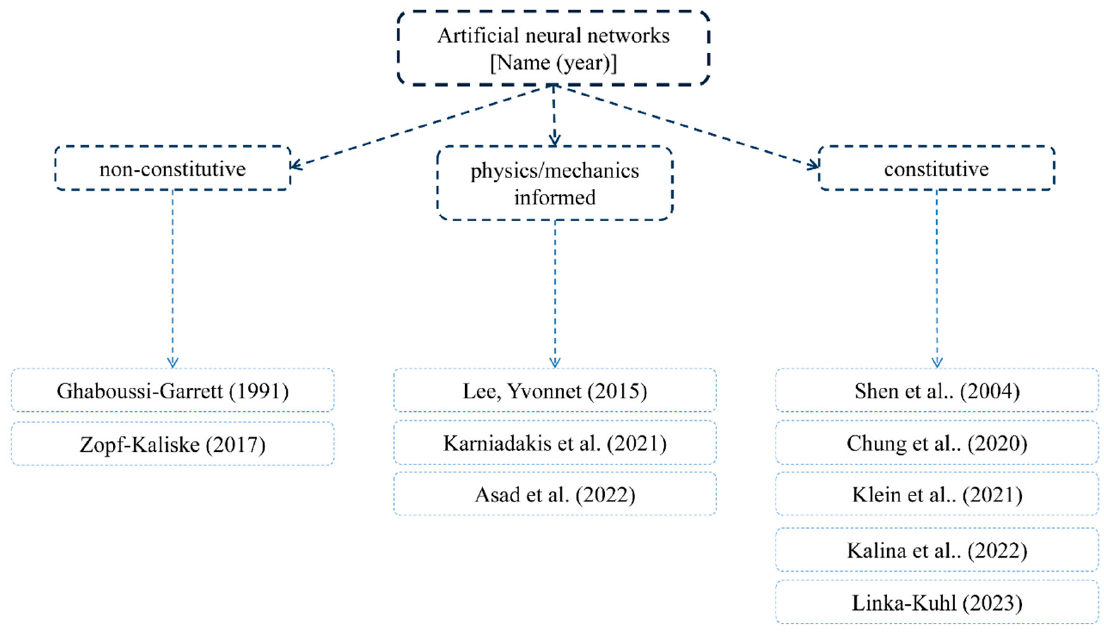
Figure 4. Different ANN (artificial neural networks) models of hyper-elastic materials.